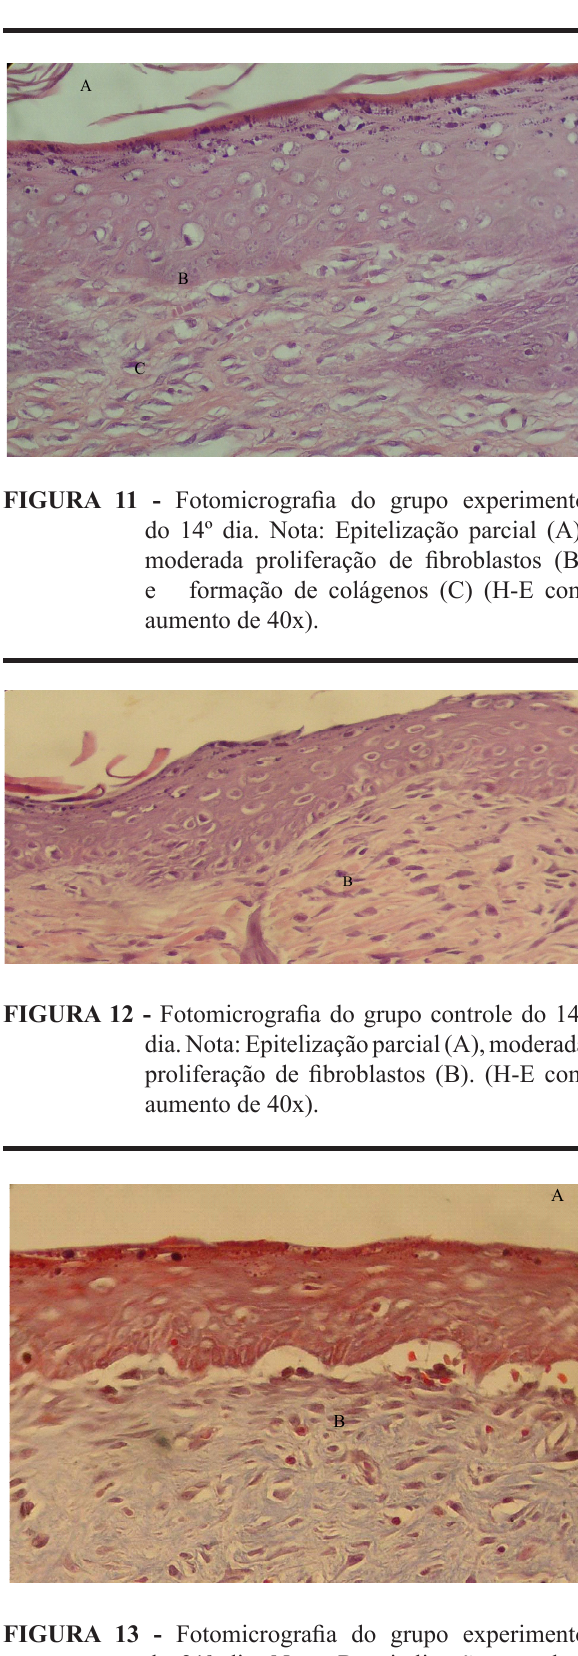
FIGURA 13 - Fotomicrografia do grupo experimento do 21º dia. Nota: Reepitelização completa (A), intensa proliferação de fibroblastos